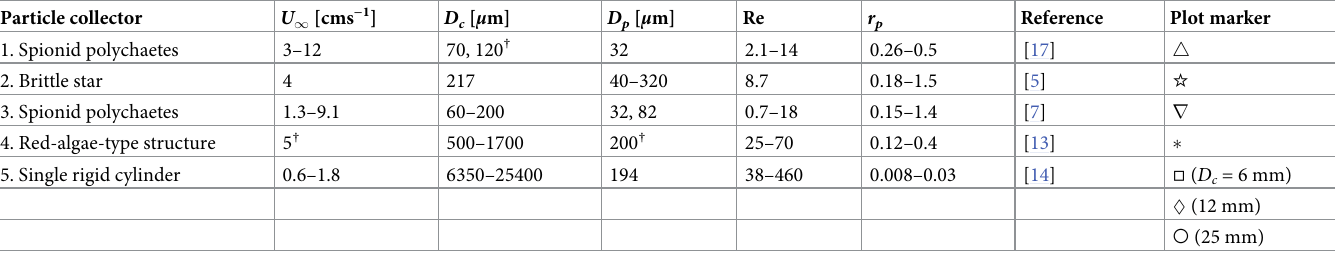
Table 3. Summary information of the experimental studies analyzed